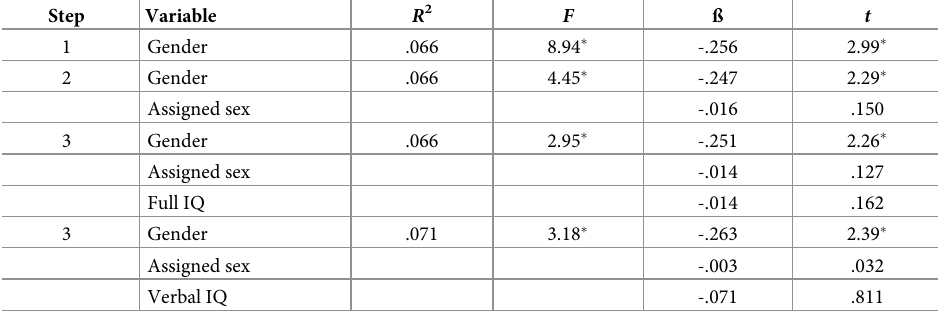
Table 3. Stepwise multiple-regression analysis of difference between left and right-hemisphere percent correct in lexical-decision